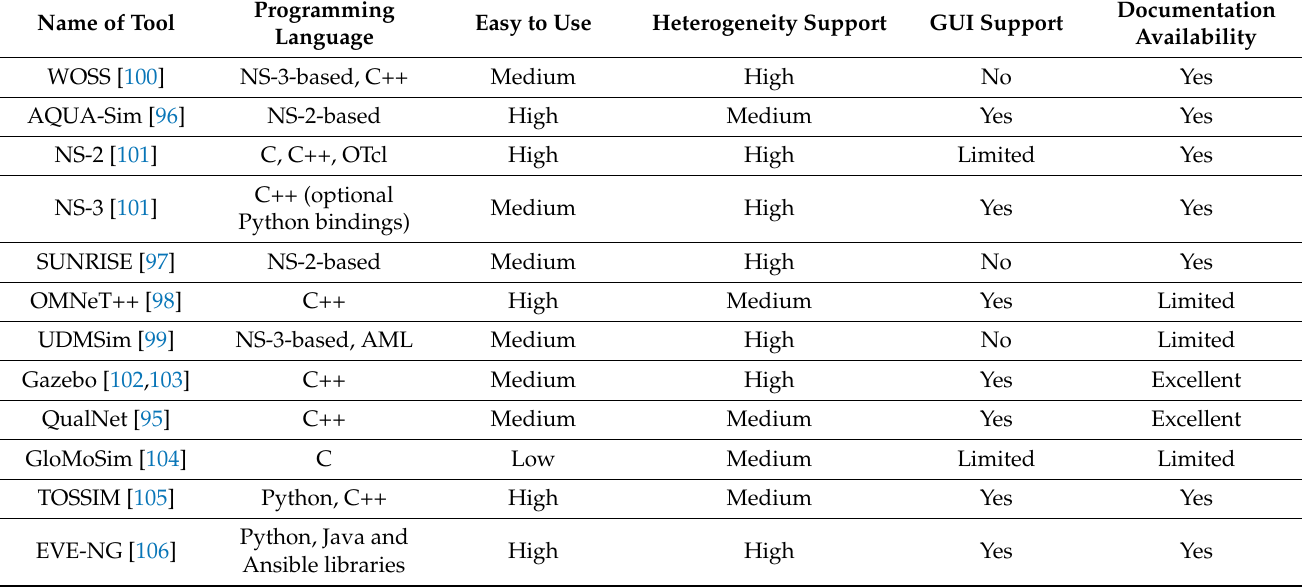
Table 3. Comparison of network simulation tools based on general information.